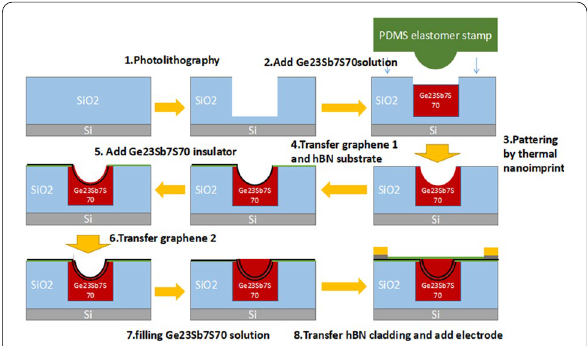
Fig. 1 Schematic process flow of the graphene-based modulator integrated in Ge 23 Sb 7 S